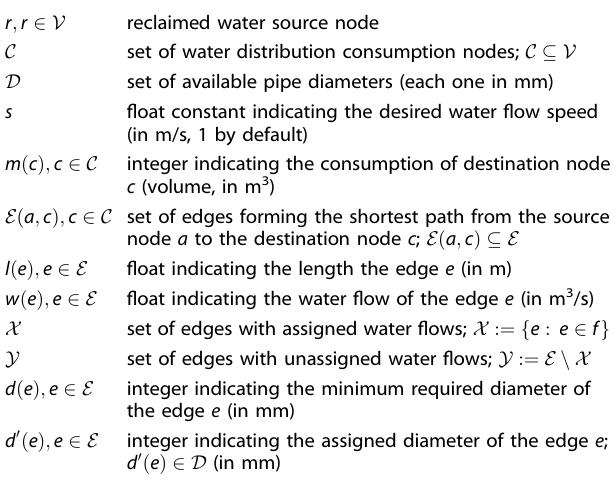
Table 6. Full notation concerning the